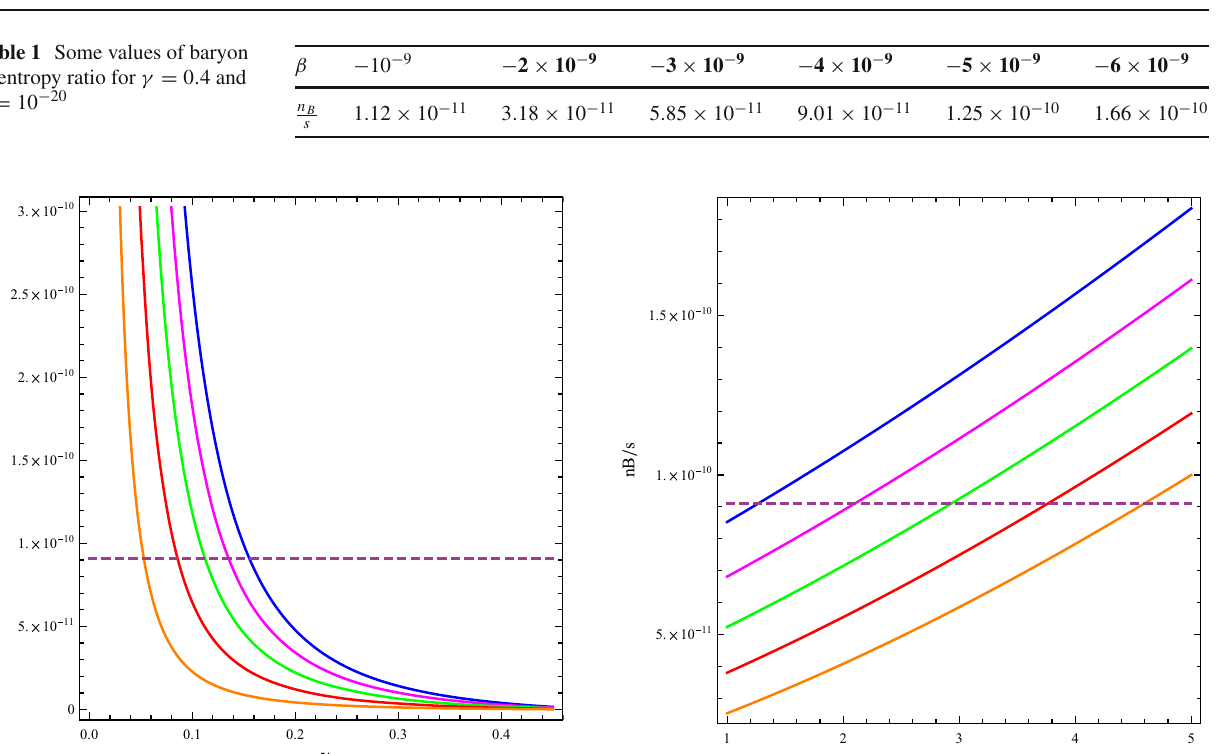
Fig. 1 The baryon to entropy ratio for the model f ( R , T ) = R + α T + β T 2 . The graphs are plotted for α = 10 − 20 and for the varying values of β , β = − 5 × 10 − 10 (blue), β = − 4 × 10 − 10 (magenta), β = − 3 × 10 − 10 (green), β = − 2 × 10 − 10 (red), β = − 10 − 10 (orange). The dashed curve represents the observational value